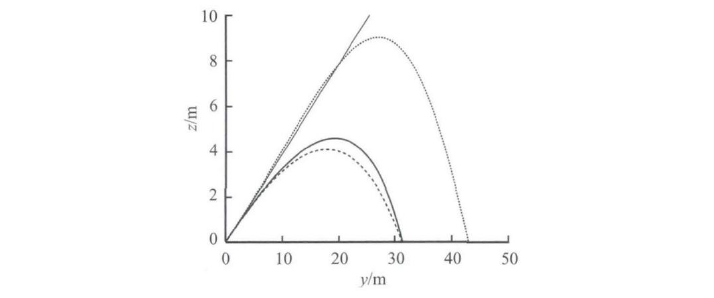
Fig. 3 Projection fine solid line of football trajectory in Yoz plane under three conditions: outgoing direction; Long line: no rotation Ω 0 = 0; Bold line: 0 = 2-2+16 rad/s Short line: 0 = 13+0+0